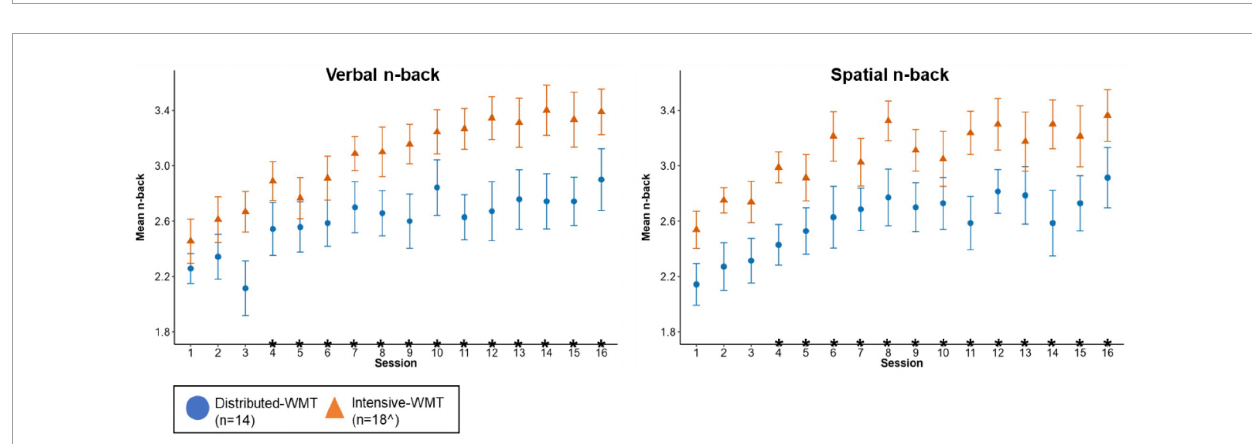
FIGURE5 Verbal (left) and spatial (right) n-back task performance as a function of training schedule [error bars represent standard error of the mean; *represents a significant difference relative to S1 across groups (i.e., a session effect); ˆfor spatial n-back S1 vs. S4 and S1 vs. S7 had n = 17 in the intensive-WMT group due to excluded data for one participant at S4 and another participant at